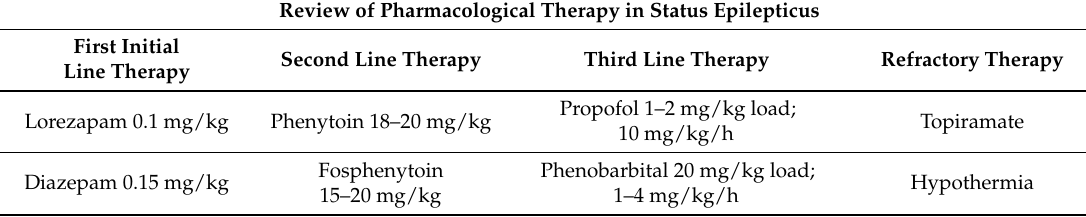
Table 4. Review of pharmacologic therapy in status